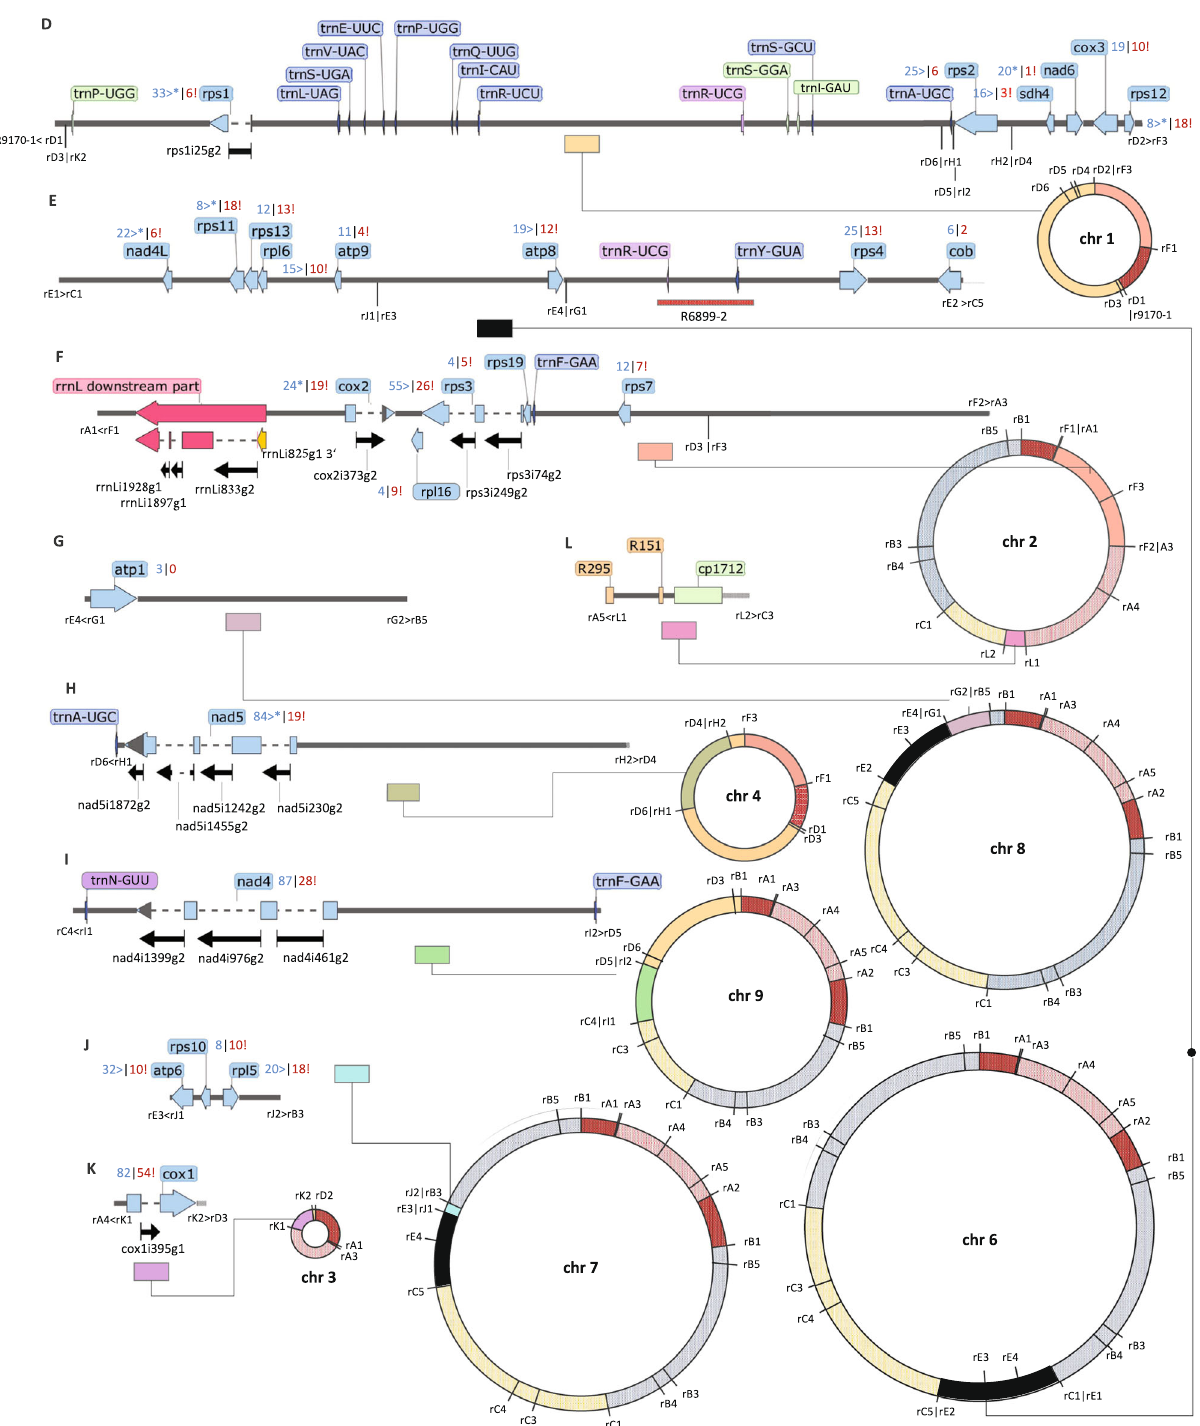
Fig. 3 The Haplopteris ensiformis mtDNA: contigs D – L and chromosomes 1 – 4 and 6 – 9. The Haplopteris ensiformis mtDNA contigs D-L are linked to recombination points in chromosome 5 (Fig. 2) or within themselves, creating further and/or alternative mtDNA arrangements. Recombination endpoints are labeled and the display of contigs and labels for genes and RNA editing events is as in Fig. 2. Possible, circular chromosomal structures chr1 to chr4 and chr6 to chr9 are around 150-fold (albeit with a broad distribution), identical repeat sequences mostly had coverages exceeding 300-fold. For clarity and discussion, we have labeled and annotated repeats with “ R ” followed by the number of nucleotides, also in the corresponding GenBank accessions.